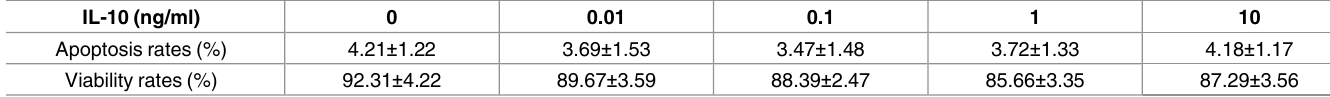
Table 1. Apoptosis and viability rates of mDCs cultured in different concentration IL-10 conditioned medium (Mean SD). IL-10 (ng/ml)